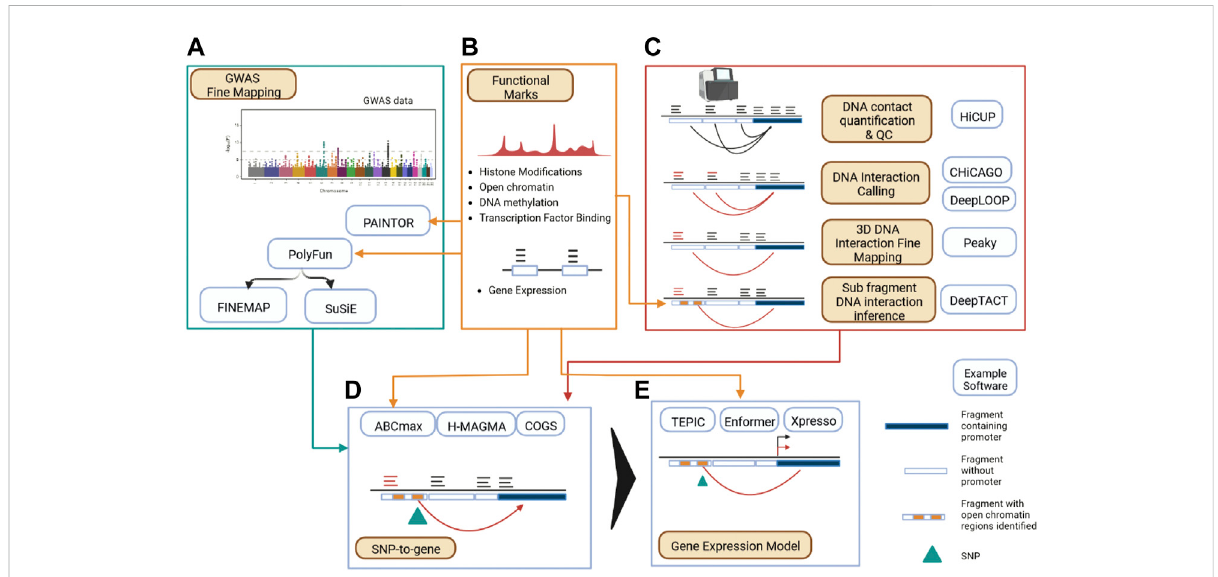
FIGURE 2 DataProcessingMapforApplying3DFunctionalGenomicstoDiseaseSNPs. (A) GWASsummarystatisticsare fi nemappedtoformcredibleSNP sets, optionally employing functional information. (B) Functional datasets can inform multiple parts of a 3D genomics backed GWAS processing pipeline, informing GWAS fi ne mapping, DNA interaction calling, linking SNPs to genes, and modelling gene expressionand regulatory networks. (C) Calling DNA interactions begins with alignment of sequencing reads to assign counts to linked restriction fragment pairs (light blue and dark blue partitions denote restriction fragments) giving a DNA contact pro fi le (denoted by dark arcs). Functional DNA interaction calling can then be performed (denoted by red arcs). Further fi ne mapping of DNA interactions and inference of DNA interactions at the sub restriction fragment (denoted by yellow blocks) level is possible given additional functional data (such as ATAC-seq). (D) Linking disease associated SNPs (denoted by green arrow) to genes in a cell type speci fi c manner. (E) Establishing the impact of genetic risk SNPs on gene